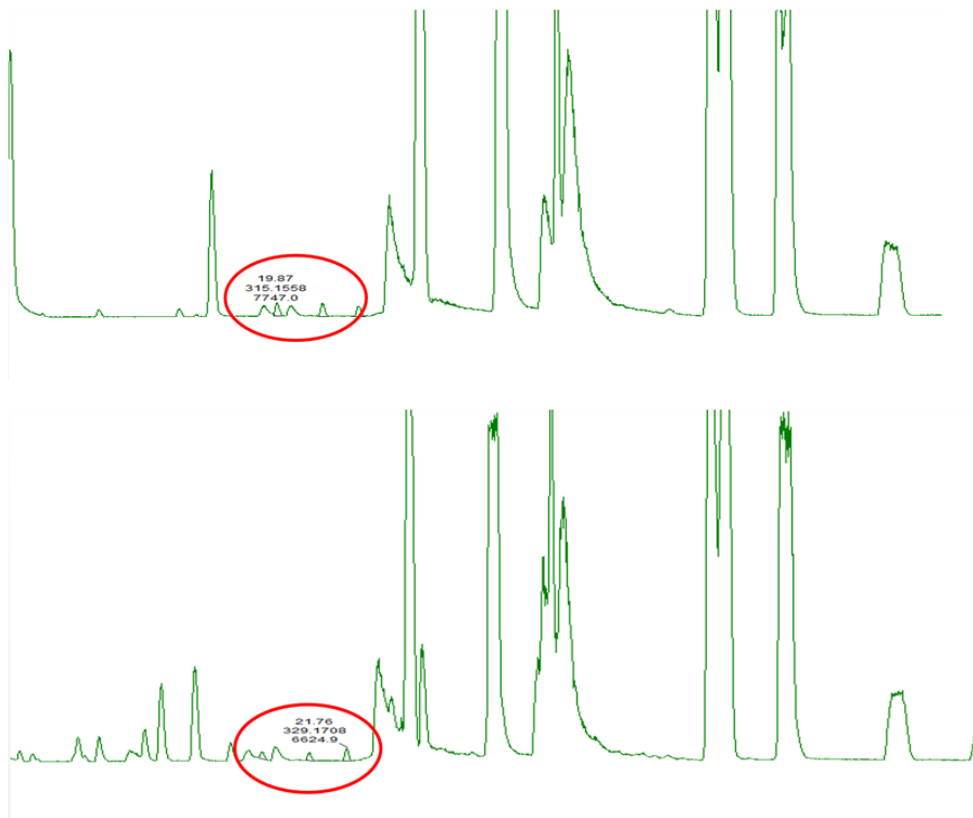
Figure 2. Determination of the content of phenolic compounds.